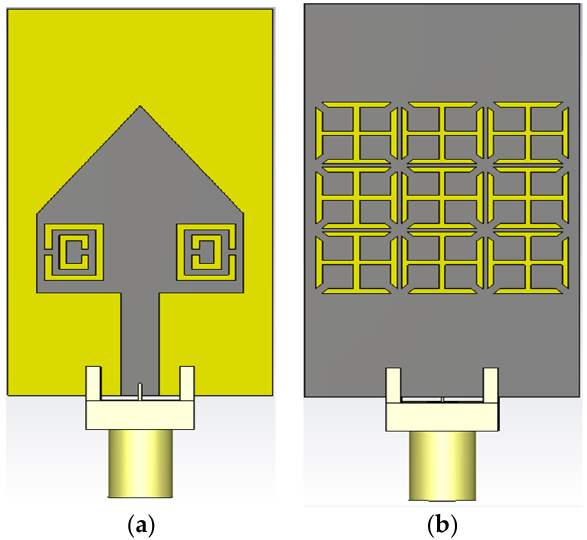
Figure 9. Layout of the proposed antenna with cross-slot MTM structure etched in the ground plane ( a ) Top Layer ( b ) Bottom layer.